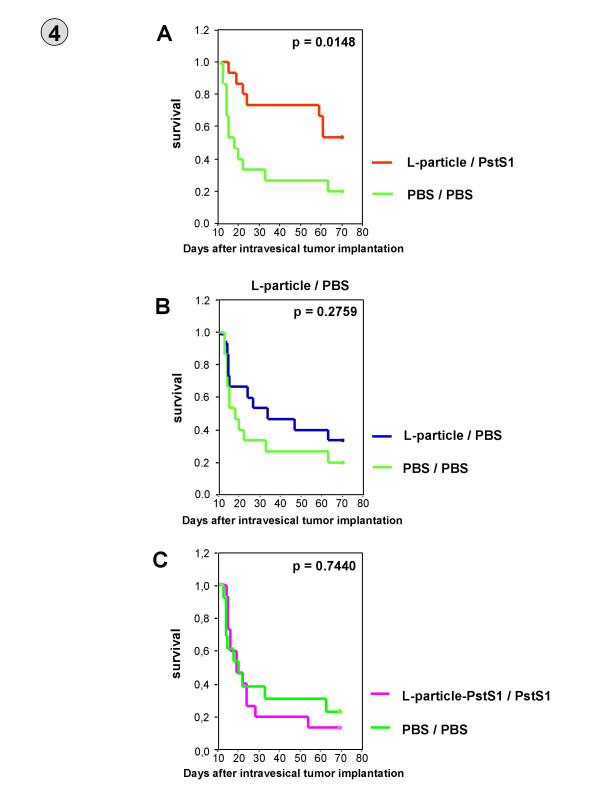
Intravesical PstS1 immunotherapy in nonsensitized and PstS1-sensitized mice. Ten days before inoculation of MB-49 tumor cells mice were s.c. sensitized by injection of empty L-particles (A/B) or L-particle loaded with PstS1 (C). On days 1, 8, 15 and 22 after tumor challenge, mice were treated by intravesical instillation of PstS1 (A/C) or PBS (B). Mice which received s.c. PBS and intravesical PBS served as control. Survival of mice was analyzed by Kaplan-Meier curve and log rank test.